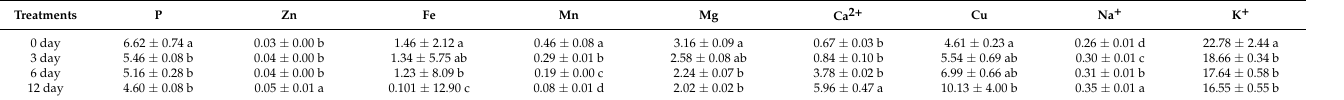
Table 1. Interactive effect of NaCl treatments on the macro and micronutrients uptake in leaves of tomato seedlings after 12 days under control and salanity